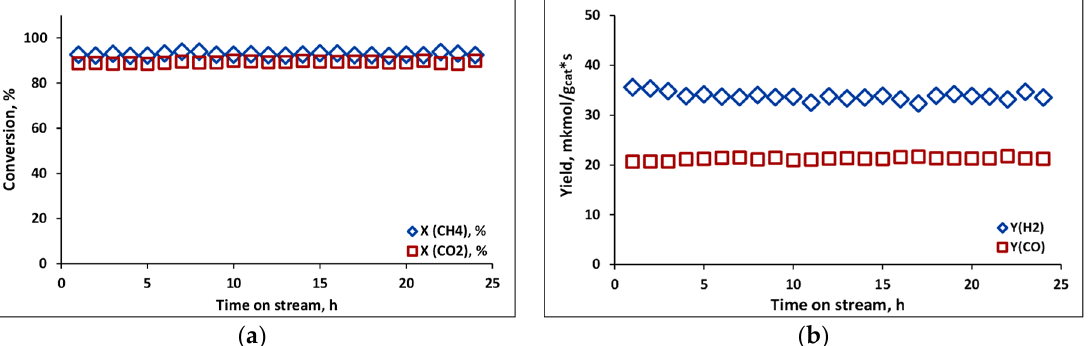
Figure 11. Dependence of ( a ) CO 2 -CH 4 conversion and ( b ) H 2 and CO yield on TOS in BRM over the 5%Co-Rh(95:5)/Al 2 O 3 catalyst at CH 4 :CO 2 = 1:1, t = 700 ◦ C, P = 1 atm, GHSV = 1500 h − 1